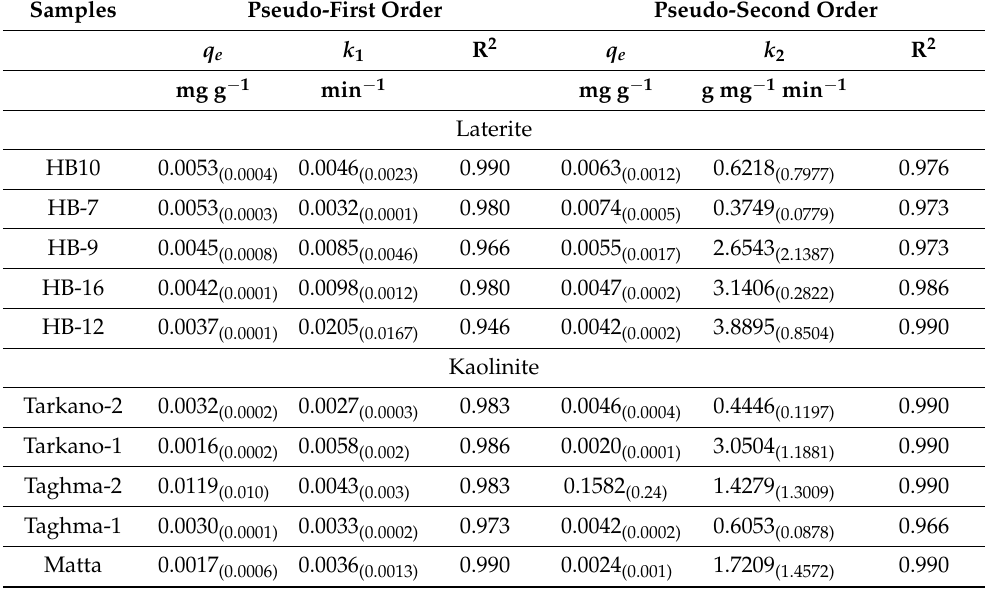
Figure 3. The pseudo-first-order equilibrium model fits for ( a ) laterite and ( b ) kaolinite and pseudo- second-order equilibrium model fits for ( c ) laterite and ( d ) kaolinite. Table 3. Pseudo-first-order and pseudo-second-order reaction model